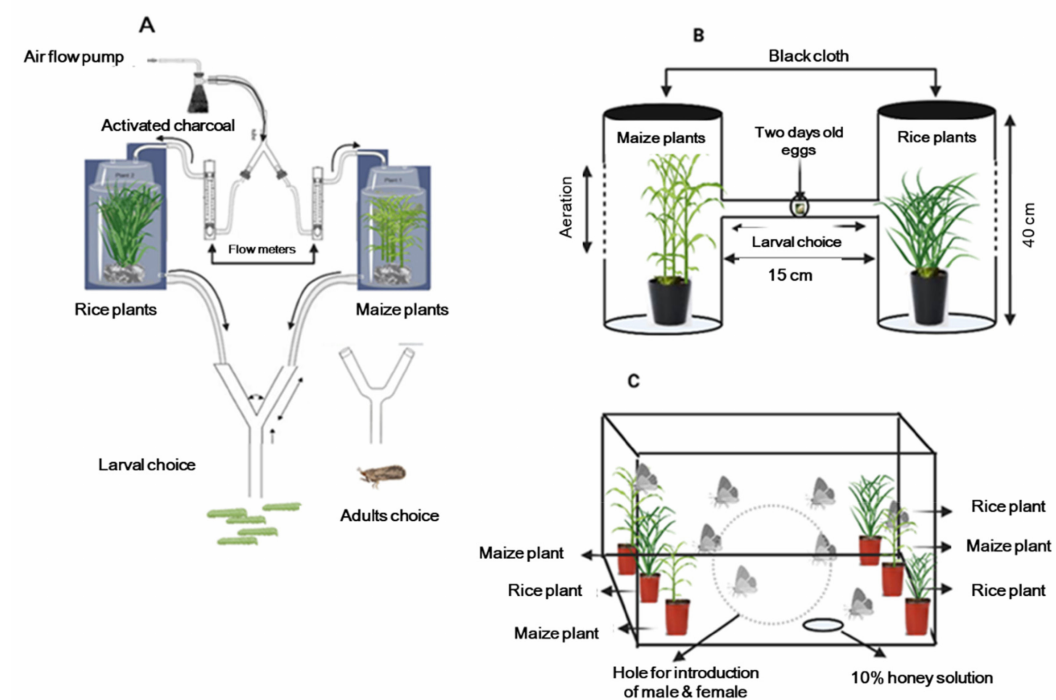
Figure 1. Graphical representation of choice apparatus used for larval feeding choice and adults oviposition preference behavior. ( A ) Y tube olfactometer set up for neonates and adults, ( B ) Choice chamber for neonates and ( C ) Cage set up for oviposition